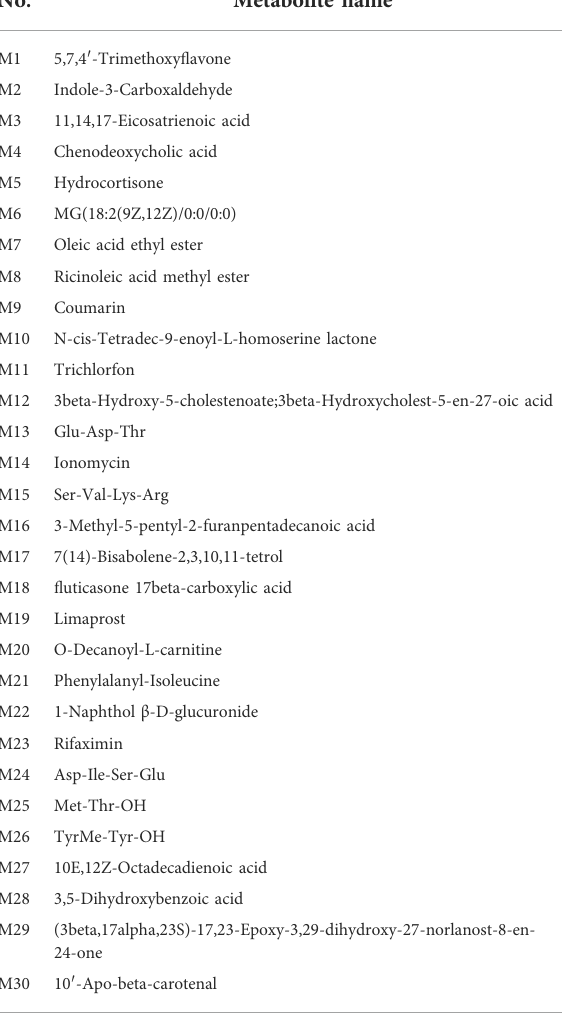
TABLE 1 Top30 metabolites according to VIP